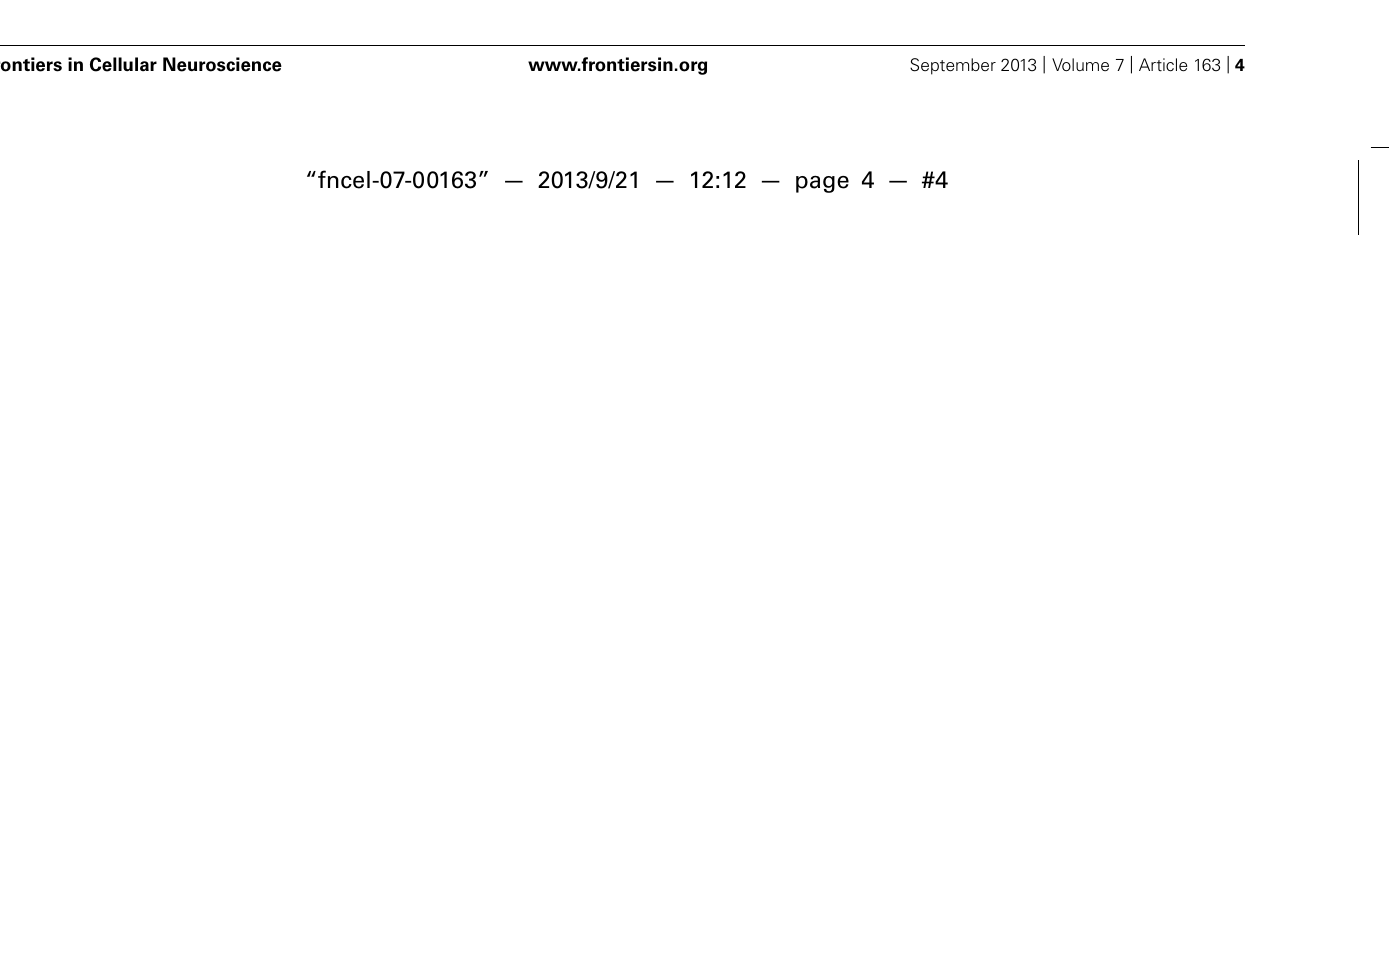
absence of target protector. The 60 nt target protector but not the 22 or 40 nt target protector recovered luciferase activity of the Pten 3 (cid:2) UTR. Neither miR-19a nor the 60 nt target protector had an effect on the luciferase activity of the full length Pten 3 (cid:2) UTR when the miR-19a binding sites were mutated. Data are presented as mean ± SEM; n = 3 luciferase assays; p values in relation to control (*** p < 0.01). n.s., not